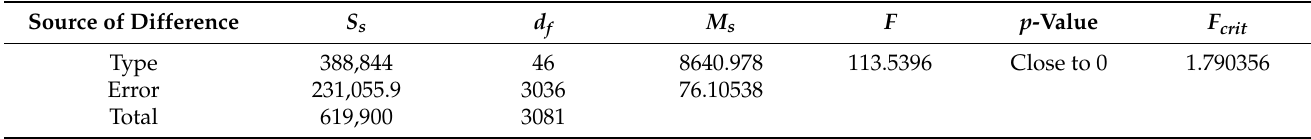
Table 2. ANOVA and significance test